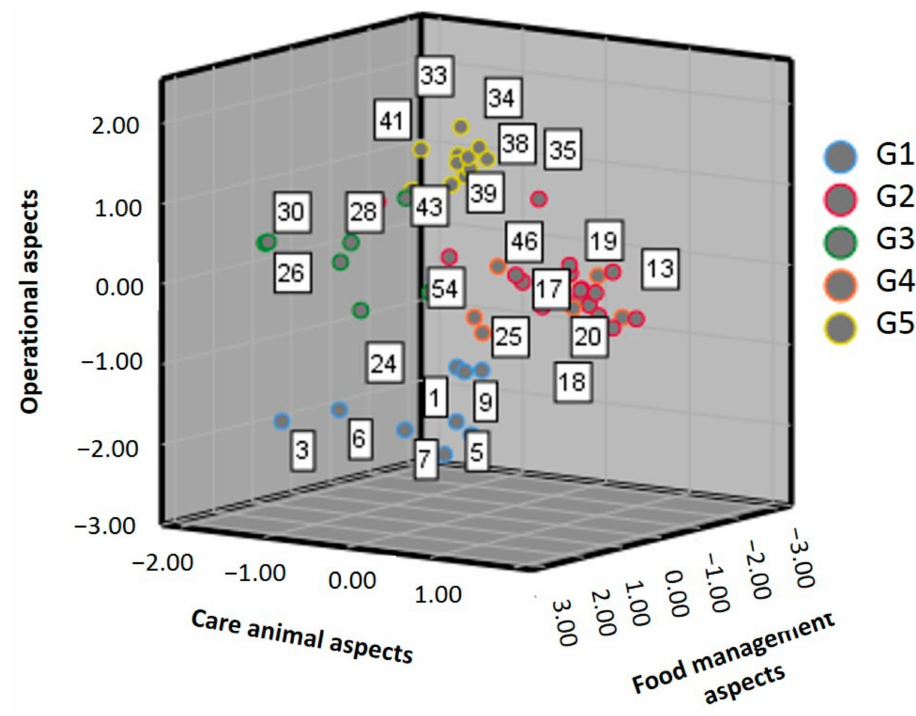
Figure 3. Cluster interaction and MCA dimensions.